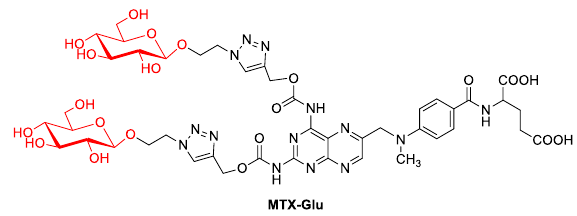
Figure 6. MTX glycoconjugate.